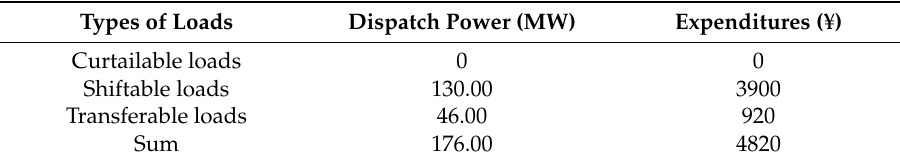
Table 8. Compensation of LA after coordinated